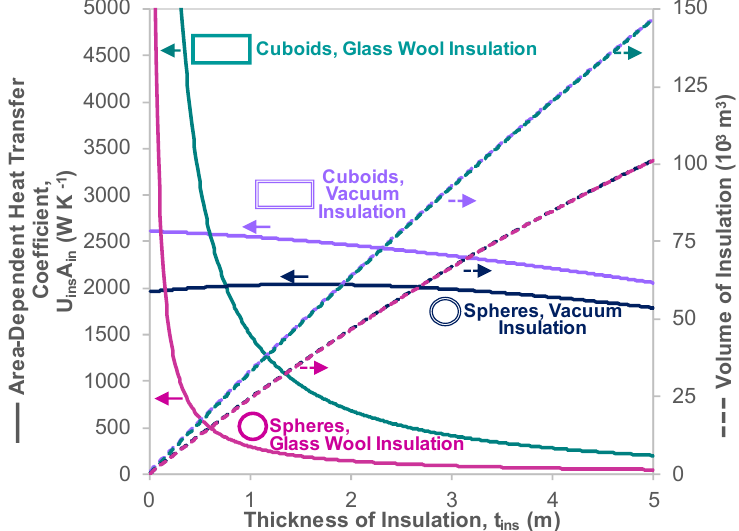
Figure A2. Variation of area-dependent heat transfer coefficient ( U ins ∙A in ) and volume with insulation thickness ( t ins ) for four spherical and cuboidal tanks insulated by glass wool and vacuum casing onboard an LH2 ship. Values are displayed for 0.01 to 5 m.